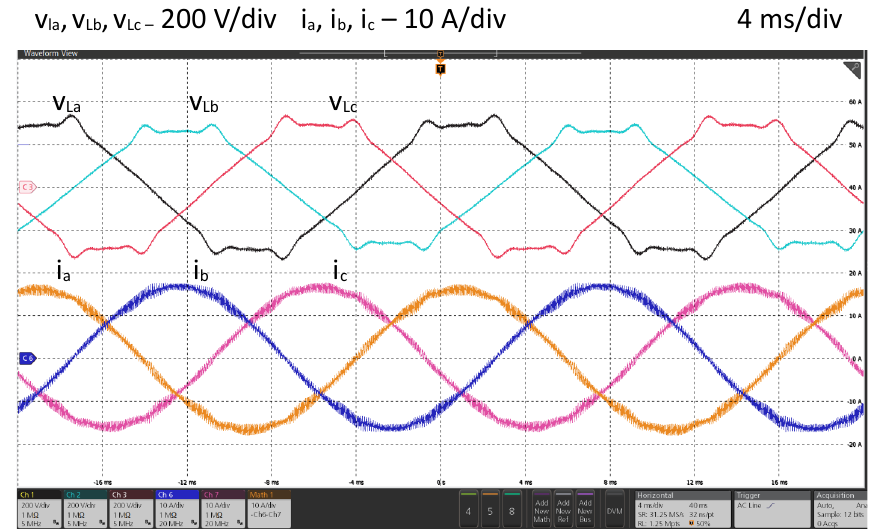
Figure 15. Experimental results of a steady state for the system with FDRC.